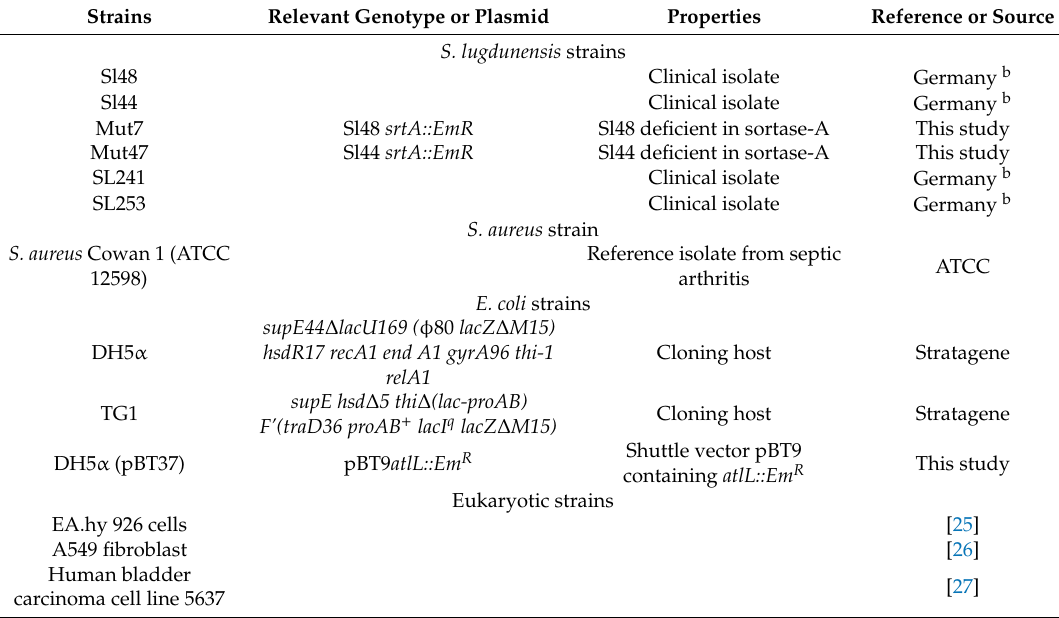
Table 1. Bacterial strains used in this